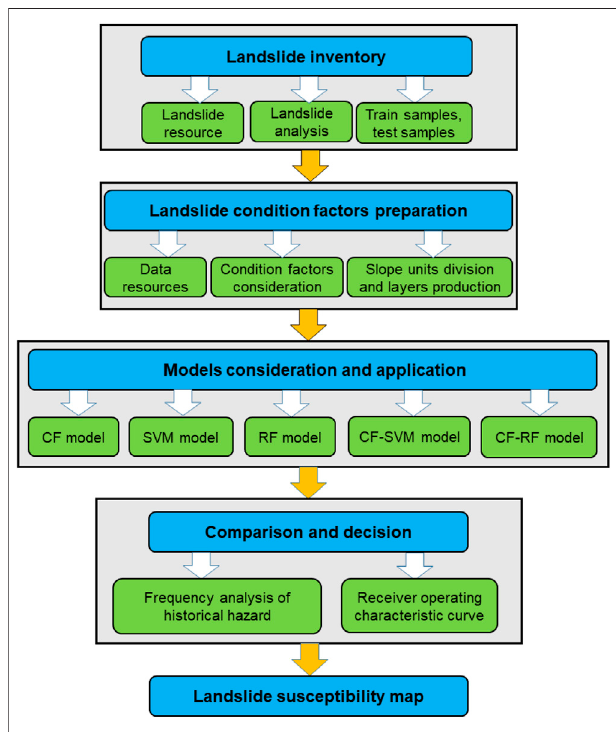
FIGURE 2 | Flow chart of the